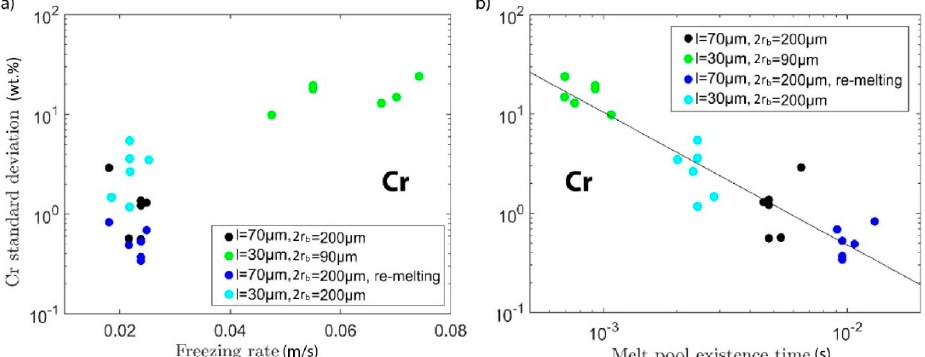
Figure 6. Re-plotting of the data from Figure 3, together with one additional set of experiments, as a function of simulated melt pool characteristics: as a function of average freezing rate of the melt ( a ) and as a function of the melt pool residence time, i.e., the time the material remains in the liquid state ( b ).